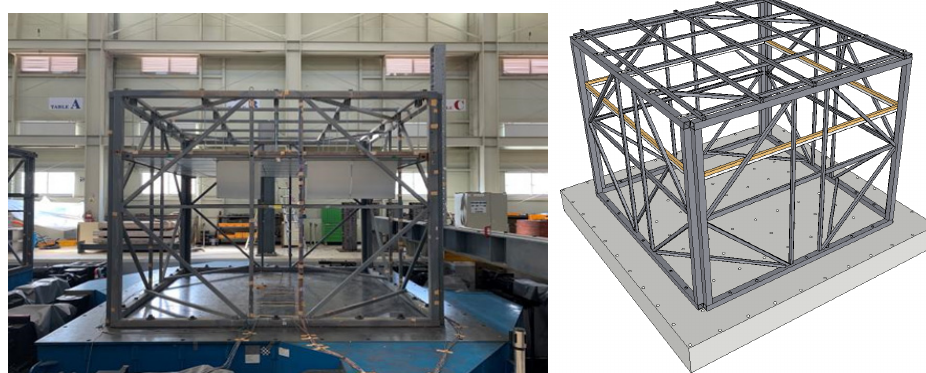
Figure 8. Test frame for shaking table test.